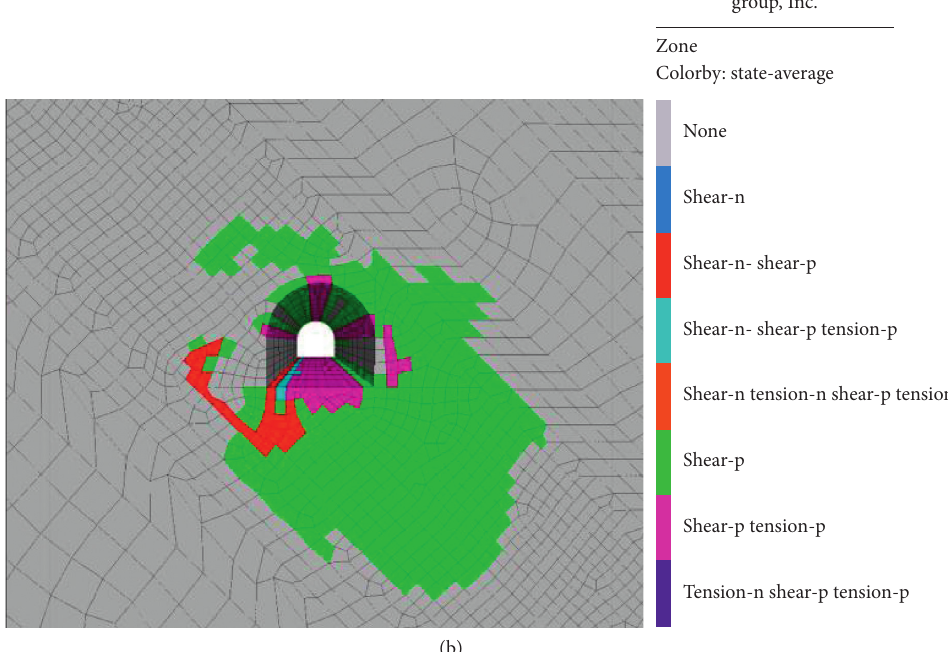
Figure 5: Distribution of plastic zone in surrounding rock of roadway: (a) without support; (b) original